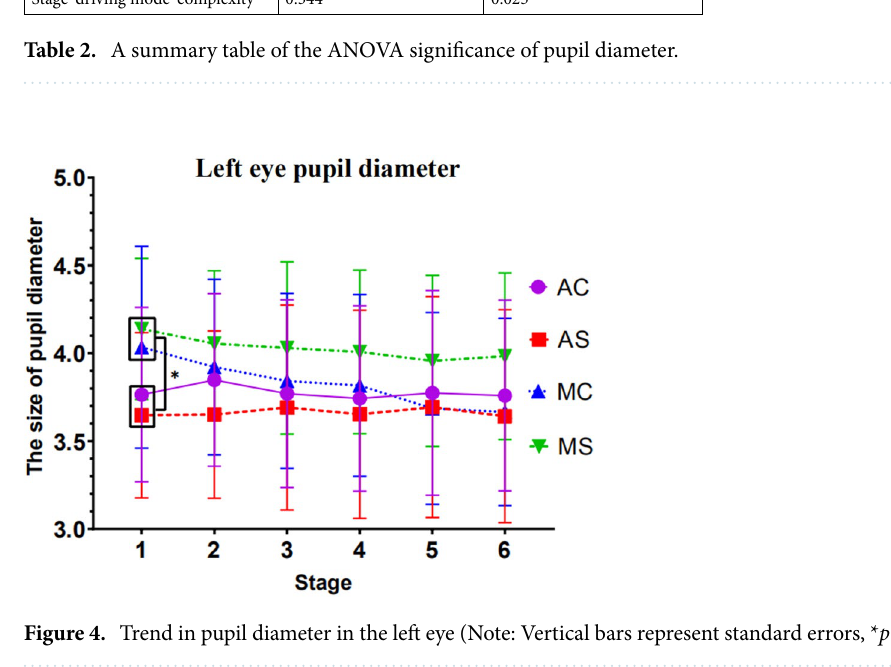
Results of left eye pupil diameter analysis. Results showed a significant interaction between stage and driving mode F (1, 54) = 8.571, p = 0.005, ηp 2 = 0.137. Simple effect tests demonstrated a significant difference between driving modes at stage 1, p = 0.004, and a significant trend at stage 2, p = 0.060. In the autonomous driving mode, regardless of the complexity of the call content, the pupil diameter of the driver’s left eye in the first stage is significantly different from that in the second stage ( p = 0.037). In manual driving mode, regardless of the complexity of the call content, the pupil diameter of the driver’s left eye is significantly different in the first stage and the second stage (p = 0.000), the stage 1 and the stage 3 were significant ( p = 0.000), and the stage 1 and the stage 4 were significant ( p = 0.000), the stage 1 and the stage 5 were significant ( p = 0.000), the stage 1 and the stage 6 were significant ( p = 0.000). The stage 2 and the stage 5 were significant ( p = 0.002), the stage 2 and the stage 6 were significant ( p = 0.002), the stage 3 and the stage 5 were significant ( p = 0.005), the stage 3 and the stage 6 were significant ( p = 0.007), the stage 4 and the stage 5 were significant ( p = 0.003), the stage 4 and the stage 6 were significant ( p = 0.010). Apart from this, no other factors or interactions reached significance. See Fig. 4 for detailed trends.